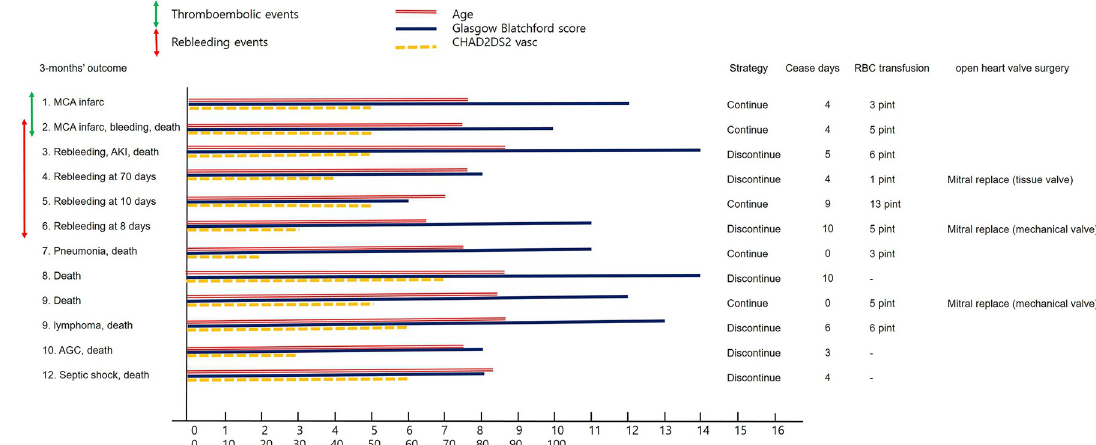
Fig 2. Each individual’s clinical thromboembolic and rebleeding events are drowned. A green line with arrowheads at both ends indicates numbered patients who had thrombotic events (#1 and #2), while a red line with arrowheads indicates the patients had a rebleeding event (#2 to # 6). Age and Glasgow Blatchford score and the CHA 2 DS 2 -VASc score were drawn for each numbered patient. The information of the anticoagulation strategies, cessation duration, amount of RBC transfusion, and history of open-heart valve surgery are filled in this figure.